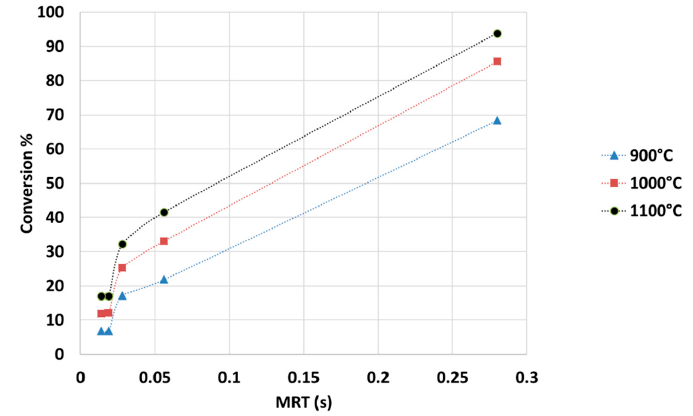
Figure 8. Effect of MRT on CO 2 conversion at different temperatures for a 1:1 CO 2 : CH 4 ratio.